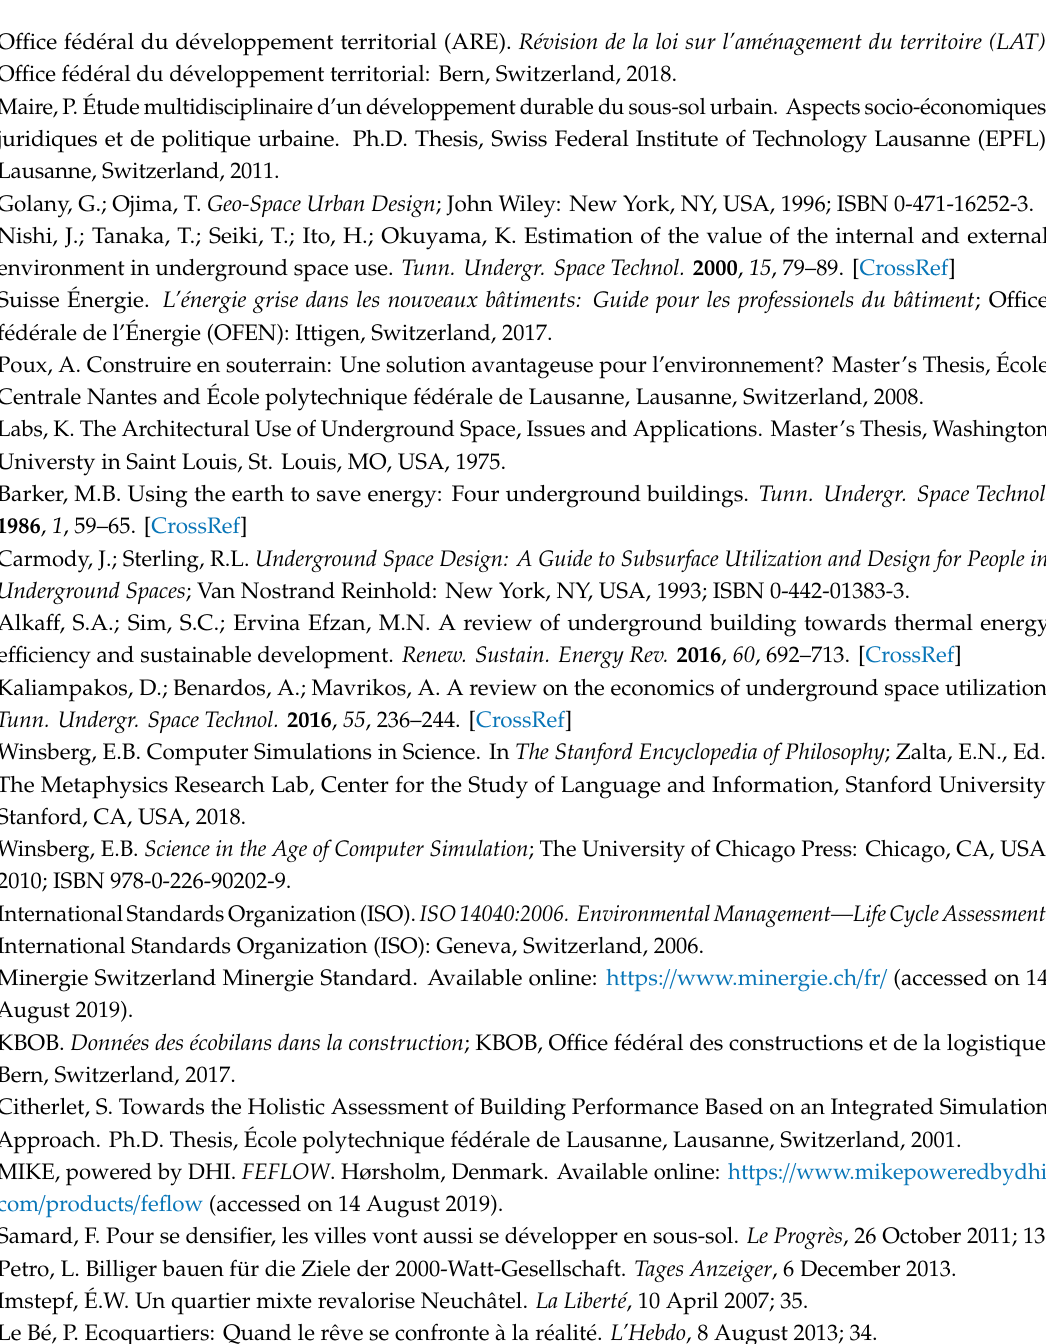
O ffi ce f é d é ral du d é veloppement territorial: Bern, Switzerland, 2018.